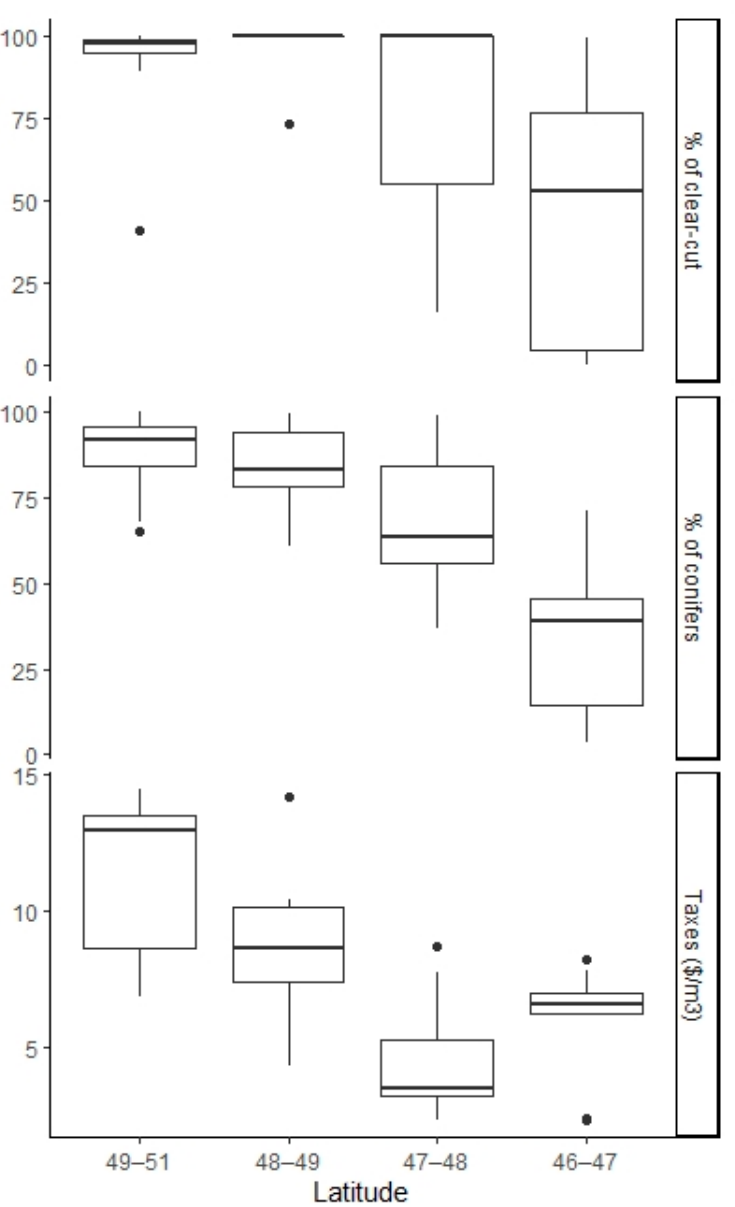
Figure 3. Boxplots of variables (% clear-cut, % conifers, and taxes $/m 3 ) used in the adjustment of the data envelopment analysis (DEA) by latitude.